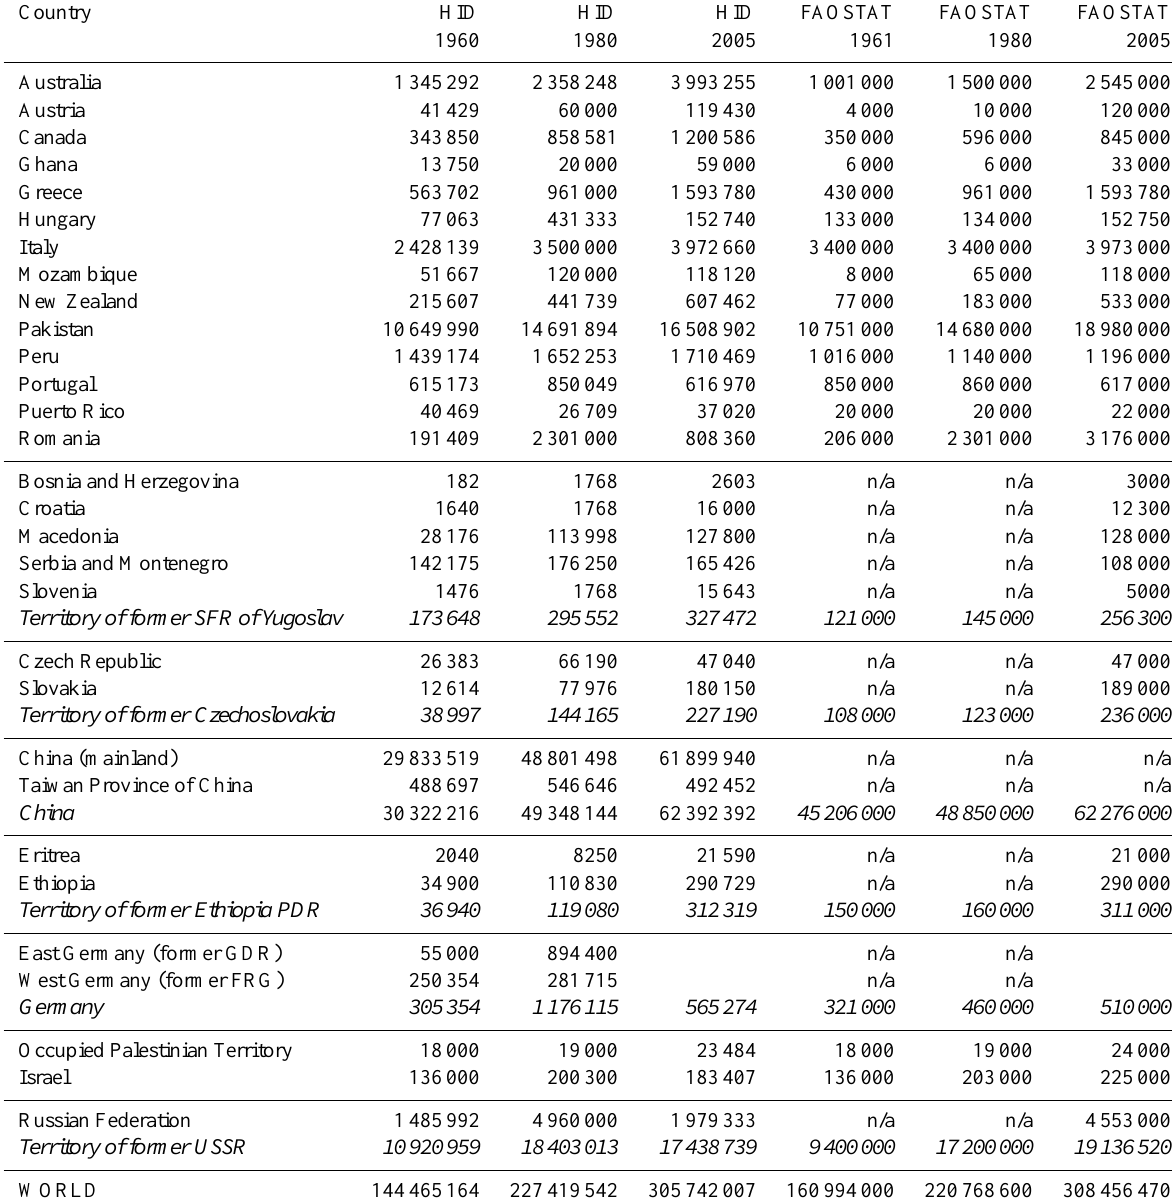
Table A1. Area equipped for irrigation (AEI) compiled from sub-national statistics (AEI_SU) in the historical irrigation data set (HID) and the FAOSTAT database (FAO, 2014b) for years 1960, 1980, and 2005 (ha). Only countries with considerable differences between AEI in HID and FAOSTAT are shown. Units are ha. Data provided by FAOSTAT (FAO, 2014b) refer to country names and country boundaries in the year of reporting while the subnational statistics of the HID refer to the current administrative setup. Data shown in italic refer to aggregated administrative units contained in FAOSTAT, e.g. the Territory of former Czechoslovakia. To allow a comparison between HID and FAOSTAT, the sum of AEI for the disaggregated units, e.g. Czech Republic and Slovakia, was computed for the data contained in the